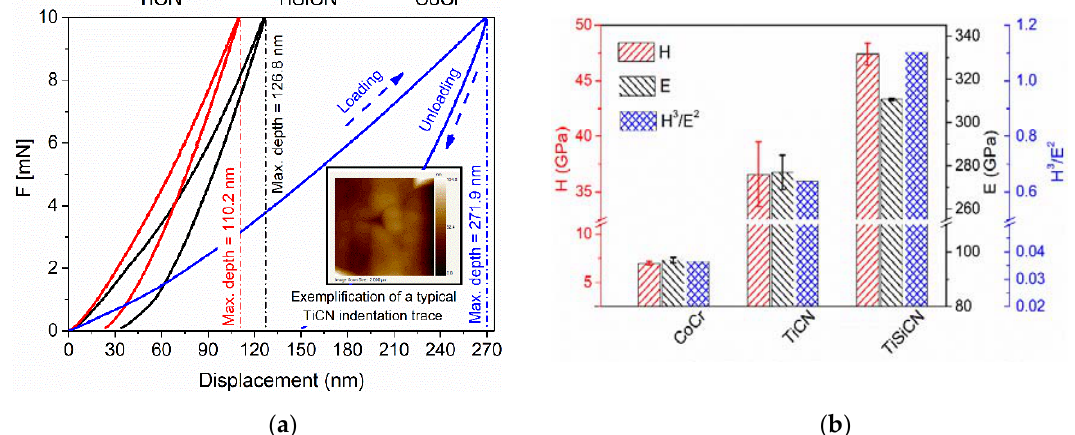
Figure 3. ( a ) Experimental force–displacement curves of the CoCr substrate, TiCN and TiSiCN coatings and ( b ) averaged hardness and reduced Young’s modulus